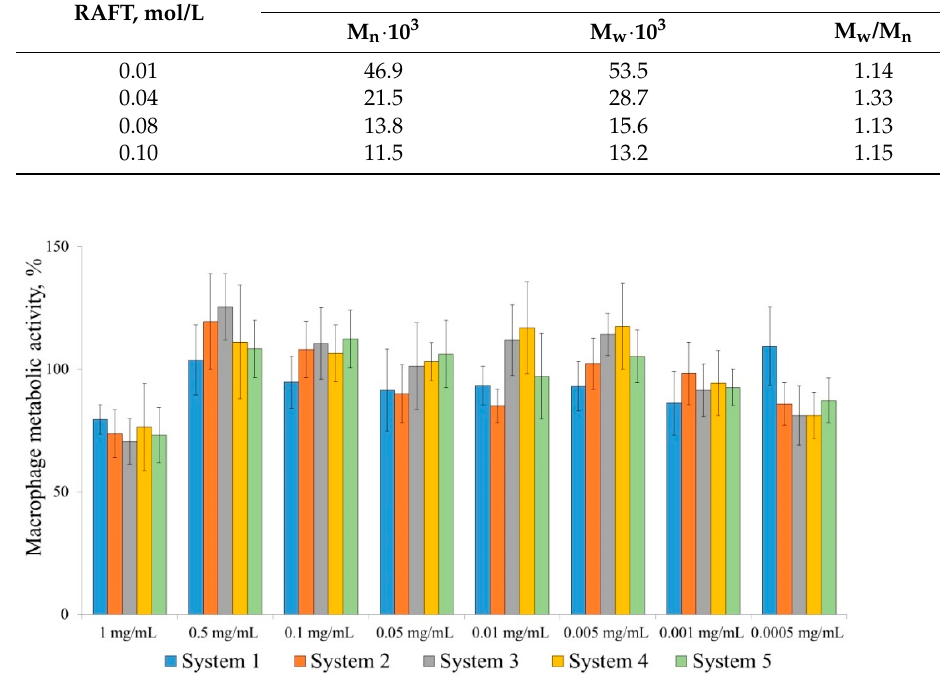
Figure 1. Metabolic activity measured in the MTT assay for peritoneal macrophages incubated with the polymers for 4 h. Data presented are the mean ± SD of eight independent experiments each performed in triplicate. System 1, polyMAA (M n · 10 3 = 16.0 Da, M w /M n = 1.47); system 2, polyMAA (M n · 10 3 = 99.2 Da, M w /M n = 1.57); system 3, polyMAA (M n · 10 3 = 19.0 Da, M w /M n = 1.45); system 4, TBMA–MAA copolymer (M n · 10 3 = 21.5 Da, M w /M n = 1.33); system 5, TBMA–MAA copolymer (M n · 10 3 = 13.8 Da, M w /M n = 1.13).